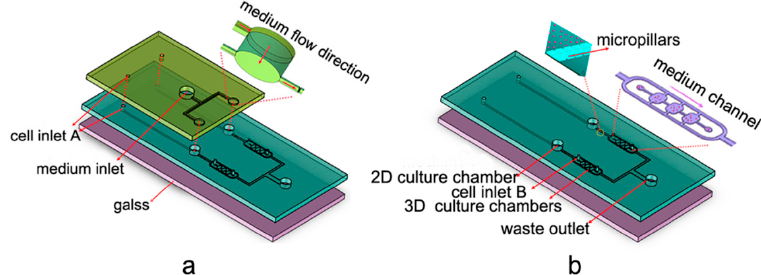
Figure 3 . Design of the microfluidic platform involving 2D and 3D culture chambers with two layers: ( a ) top layer; and ( b ) bottom layer [80].